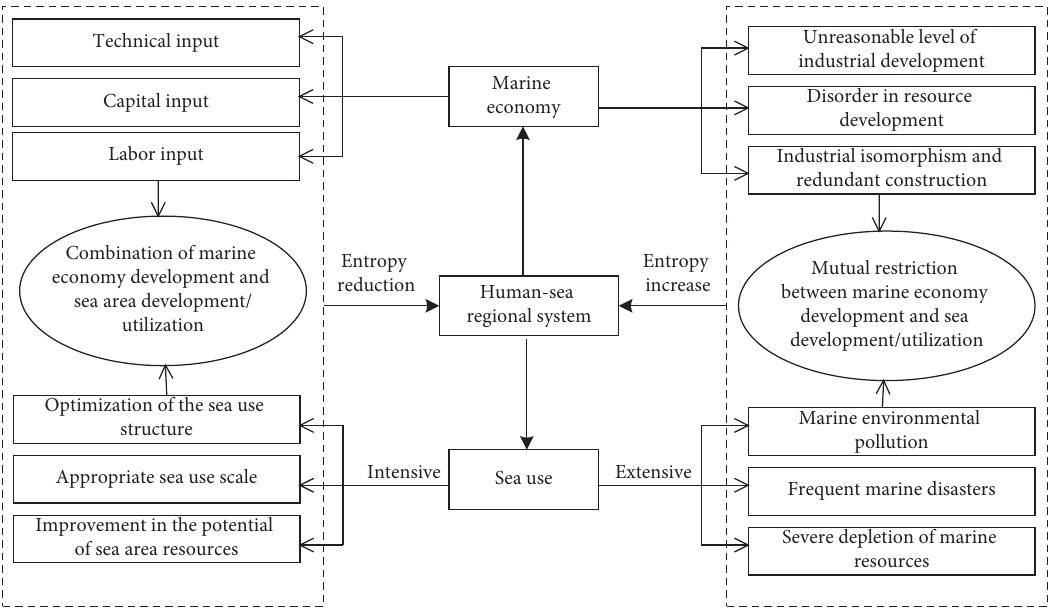
Figure 1: Mechanism of interaction between intensive utilization and the marine economic system in sea